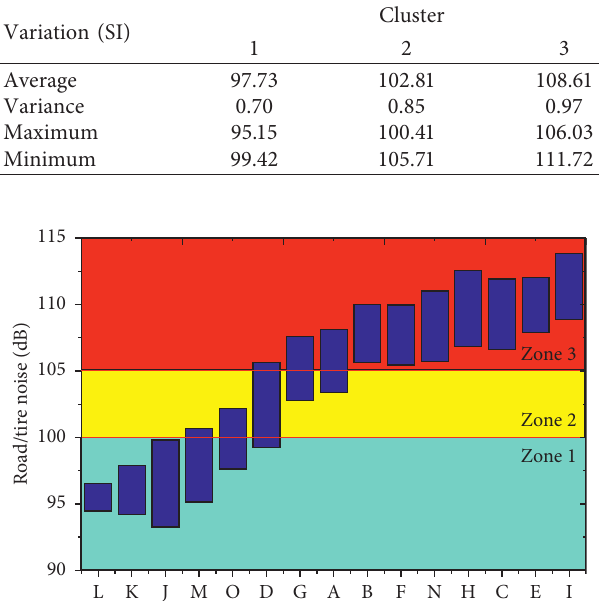
Figure 8: Concrete pavement noise zoning results.